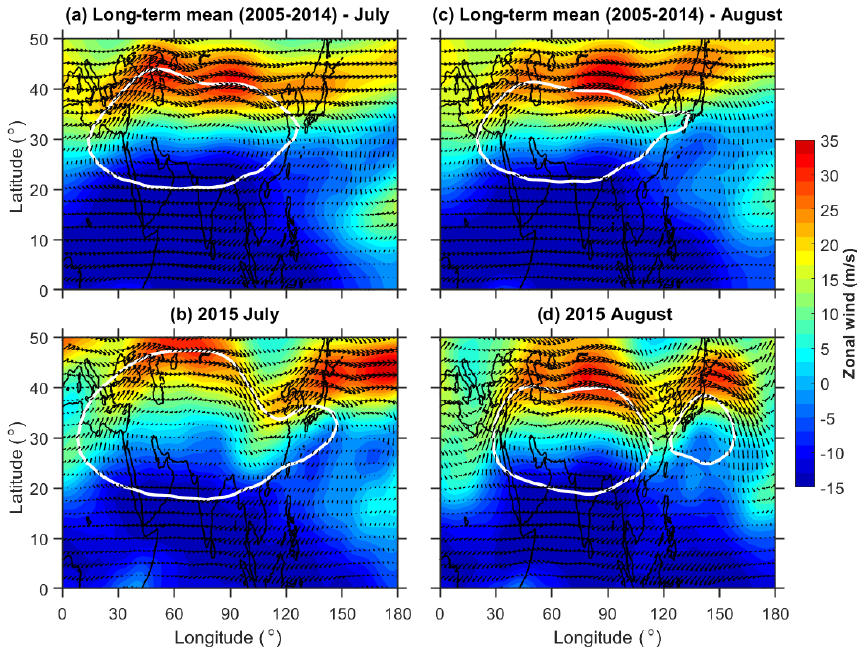
Figure 4. Spatial distribution of monthly mean zonal winds obtained from NCEP-DOE Reanalysis 2 data at 200hPa in July during (a) 2005– 2014 and (b) 2015. Subplots of (c) and (d) same as (a) and (b) but for the month of August. The solid white contour lines represent the ASMA region at 100hPa (16.75km GPH contour).